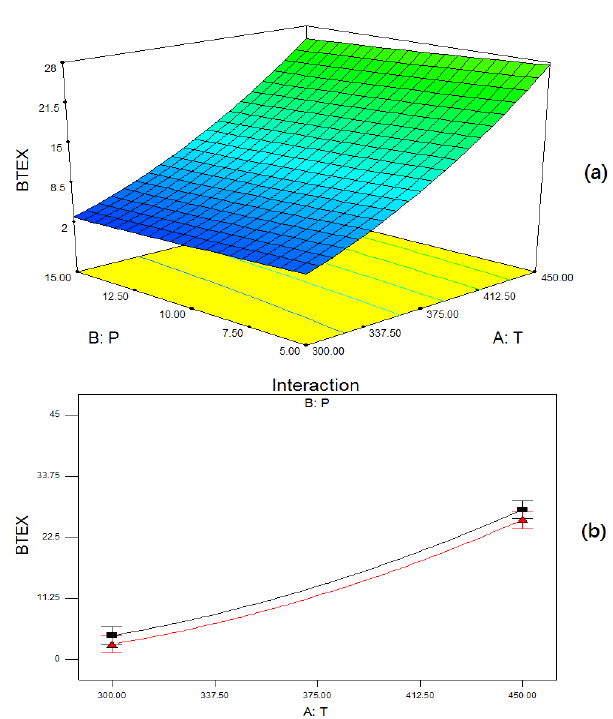
Figure 7. Interaction effect study between (B) pressure and (A) temperature, under BETX (mol%) production. ( a ) 3D surface plot and ( b ) interaction plot.